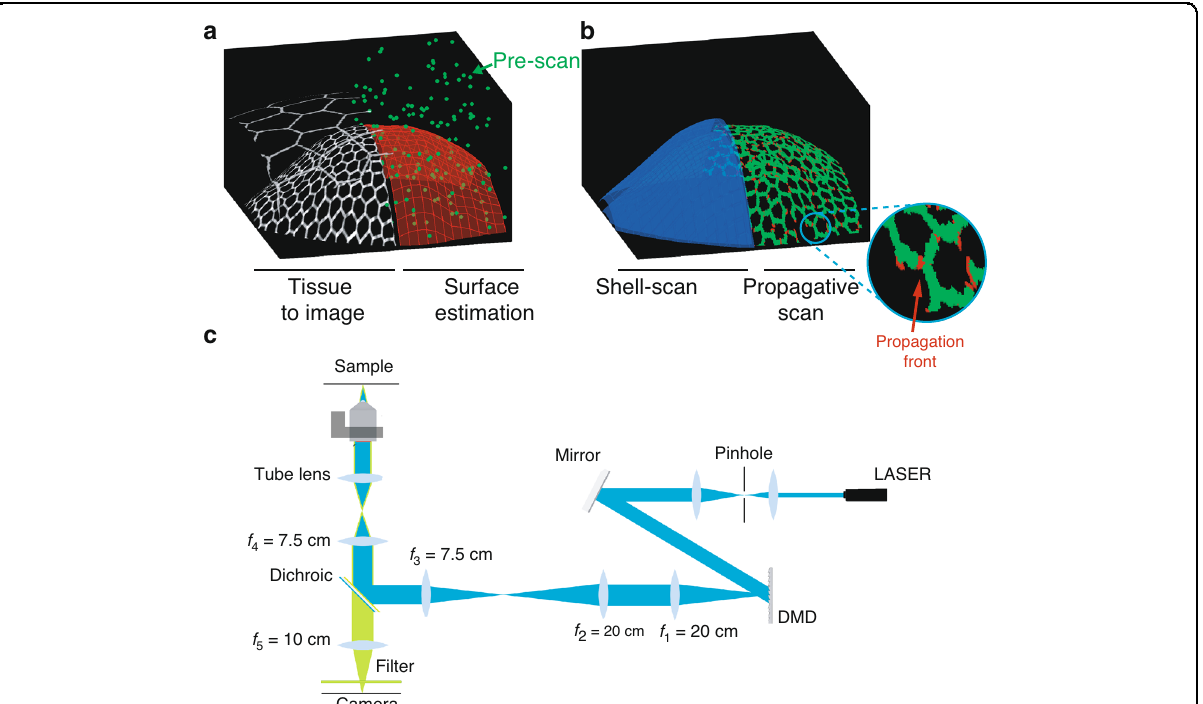
Fig. 1 Approach and experimental set-up. a , b Schematic of the approach. a Left: Drawing of a curved epithelial tissue. The tissue may be overlaid by a second epithelium to be discarded by the imaging process. Right: We fi rst estimate the surface of interest (red mesh) using a small fractional pre- scan (green dots). b After surface estimation, we either scan a thin shell (blue) around the surface of interest (left side) or we propagate the scanning process along the cell outlines (right side). The zoom in the inset shows the propagation front in red while the previously sample voxels are in green. c Experimental